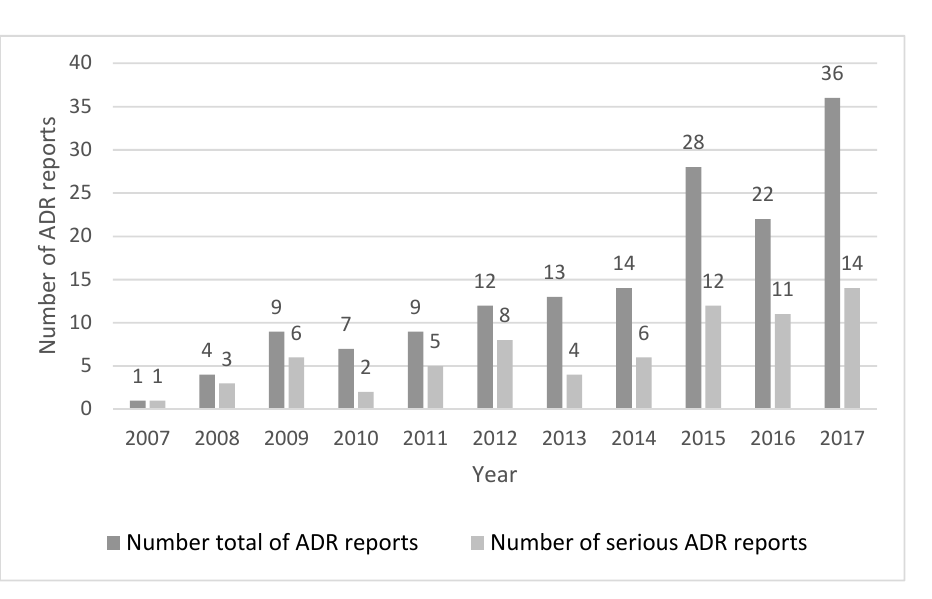
Figure 1. All suspected adverse drug reactions (ADRs) reports versus the serious reports per year.